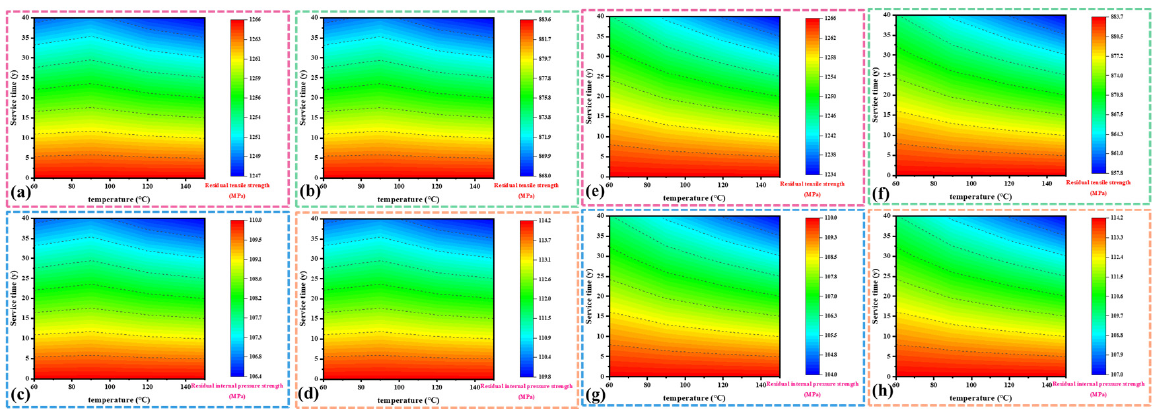
Figure 17. Residual collapse strength of G3 ( a , c , e , g ) and G3 ( b , d , f , h ) steels in gas ( a , b , e , f ) and liquid ( c , d , g , h ) phase (( a – d ): 0–2000 m; ( e – h ): 2000–4700 m).